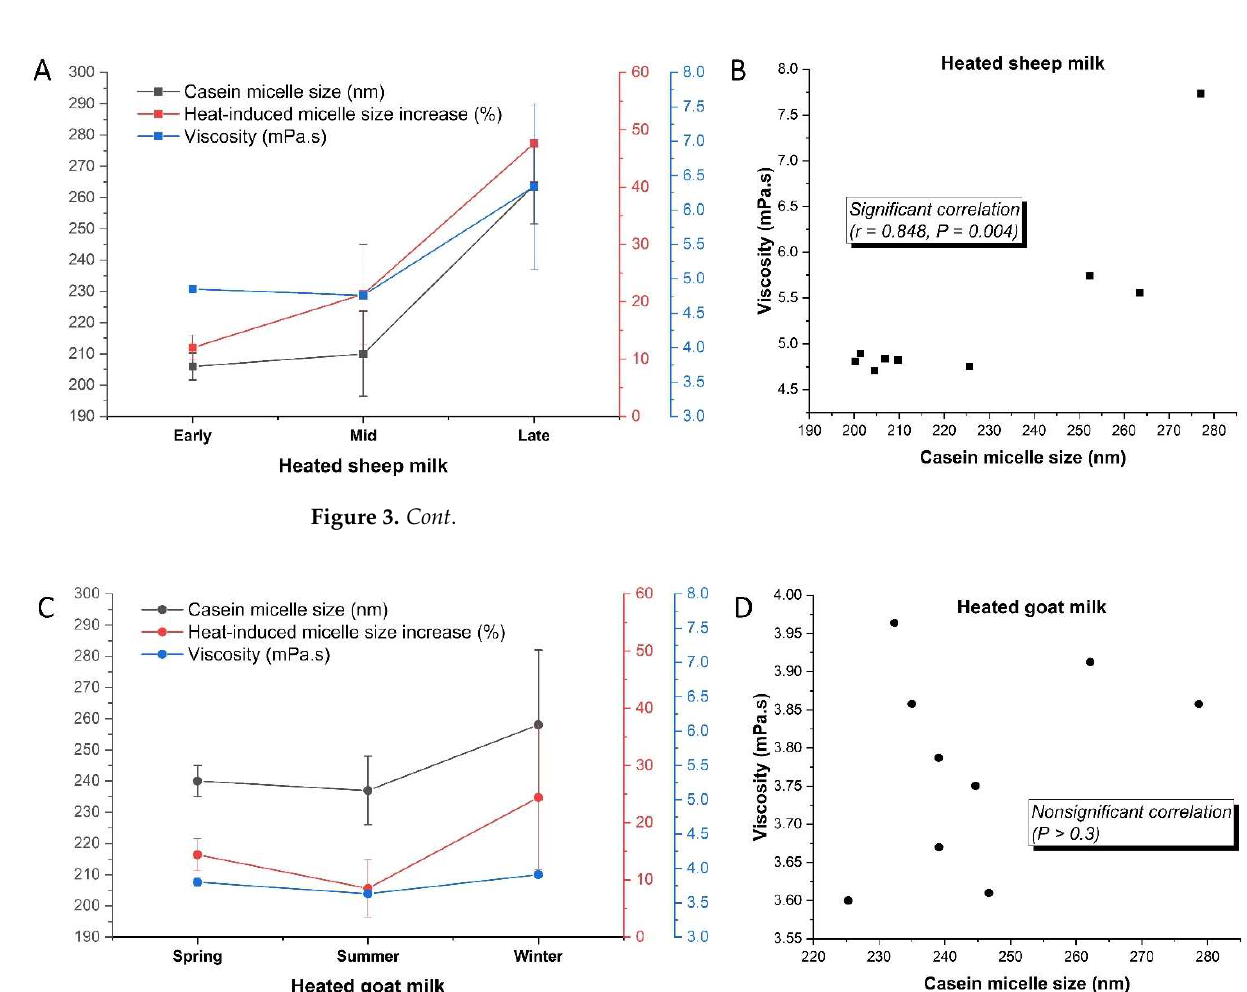
Figure 3. Casein micelle size (black), heat-induced micelle size increase (red), and viscosity (blue) of homogenized-heated (95 °C for 5 min) ( A ) sheep milk and ( C ) goat milk (Y-axes are indicated by corresponding colors in the legends) and correlations between casein micelle size and viscosity of heated ( B ) sheep milk and ( D ) goat milk.